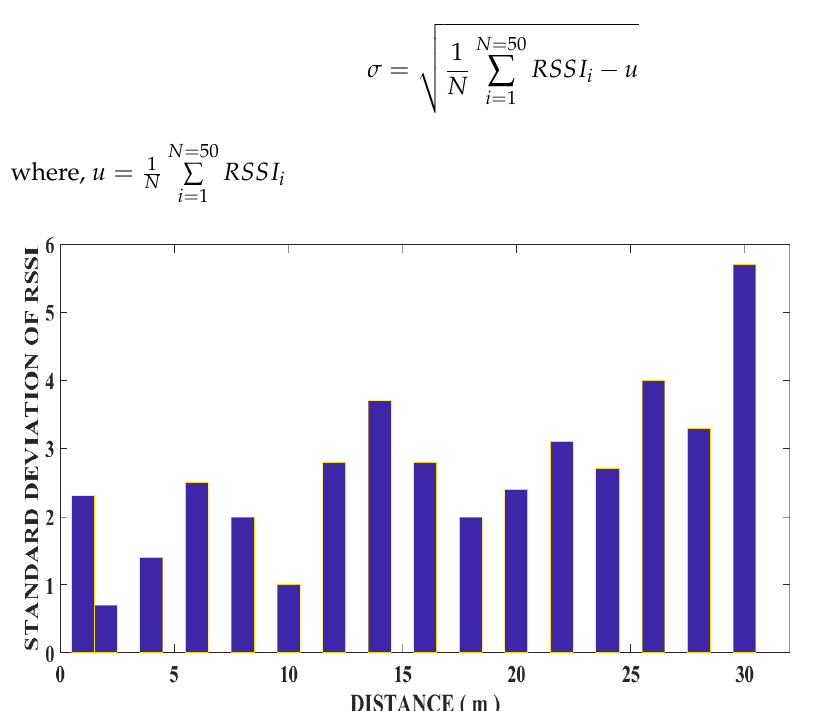
Figure 17. Standard deviation for device 1.